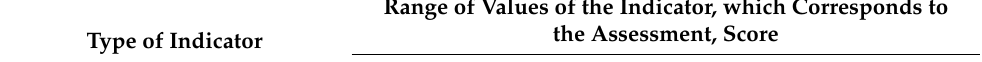
Table 1. The scale for the qualitative treatment of the value of the indicators of quality of life, which characterise the risks of smart cities. Range of Values of the Indicator, which Corresponds to the Assessment, Score Type of Indicator Low Value Moderate Value High Value above 75 50–75 below 50 below 50 50–75 above 75